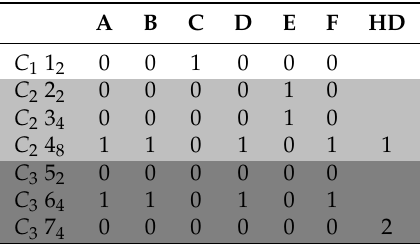
Table 4. Example of a second assignment in the grid for the Figure 2 DAG task using the DAG task paths (each solution is shown in a different shade of gray).